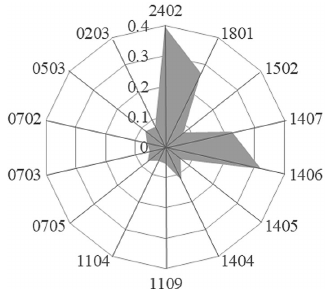
Figure 9. The function of the weighted clustering coefficient with respect to node strength Figure 10. Betweenness